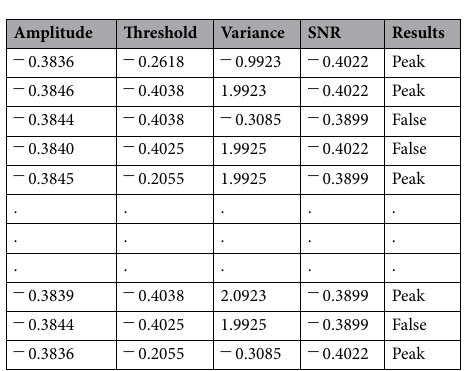
Table 4. Final dataset after pre-processing and features